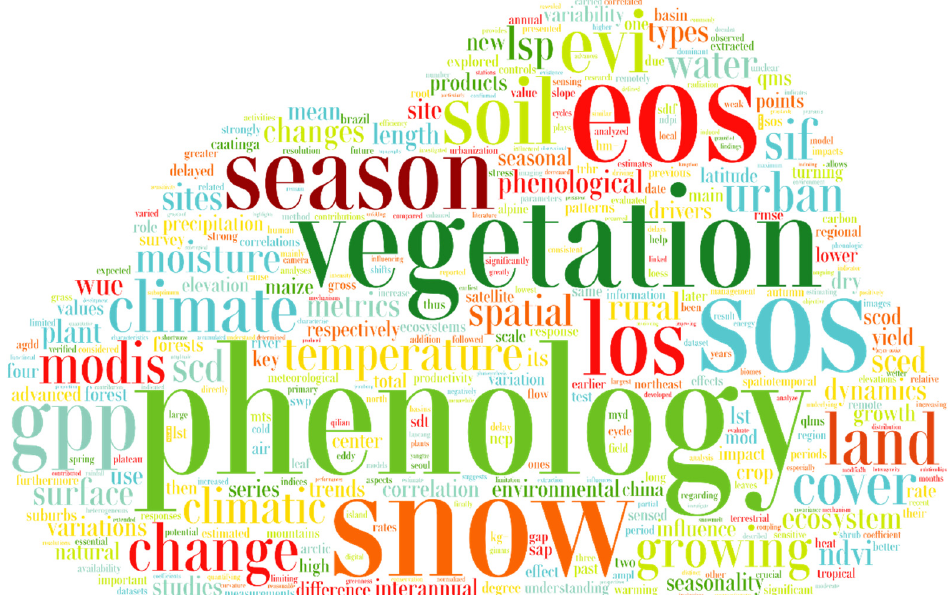
Figure 1. Cloud of the words contained in the abstracts of the papers published in the Special Issue “Remote Sensing of Land Surface Phenology”. The bigger the size, the higher the frequency of each word.